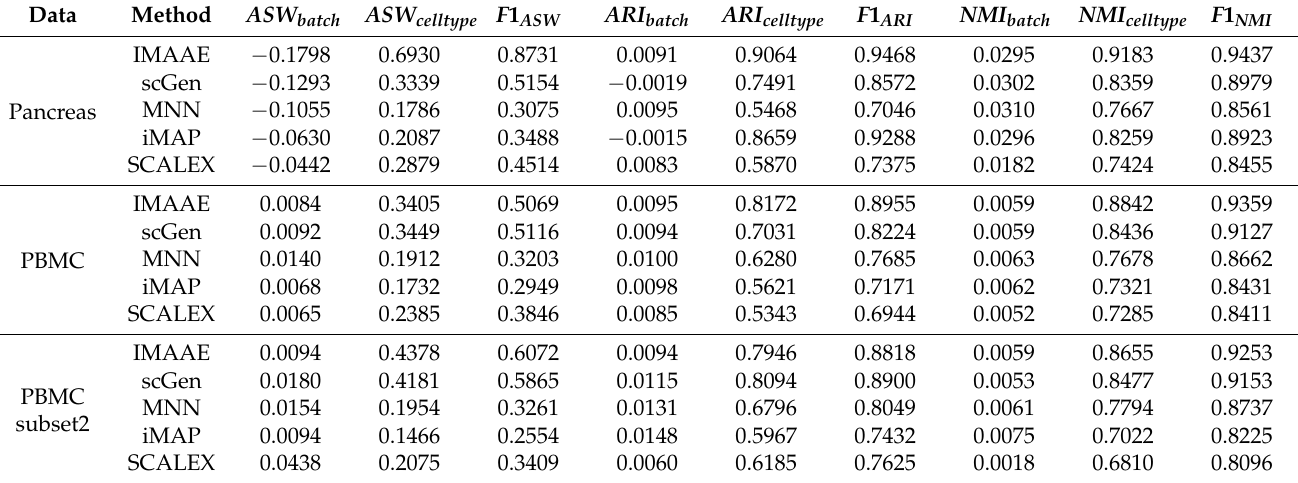
Table 1. Quantitative assessment of batch effect correction methods using ASW , ARI , NMI , and corresponding F 1